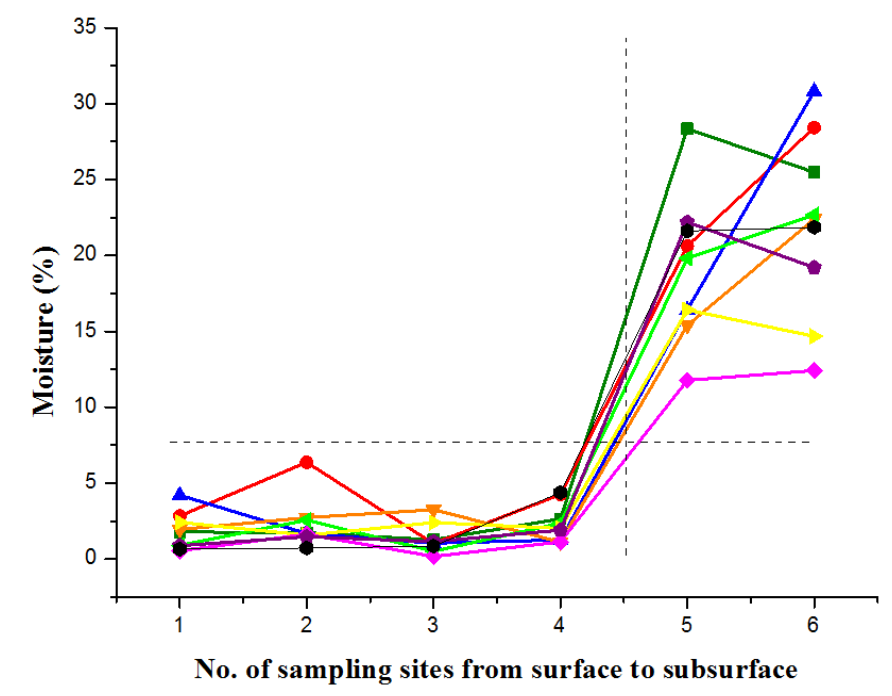
Figure 2. Moisture variation from surface to base of the lacustrine deposits at selected sampling sites. It can be seen that the moisture increased abruptly rather than gradually from the fourth sample (average depth of 40 cm) to the fifth sample (average depth of 50 cm) counting from surface to base in each sampling pit. The fourth and fifth samples were from different depths at different sites. The average moisture of the first four samples was approximately 2%, but the moisture of the fifth sample increased to 10% at least. The dash line in the figure stands for the significant